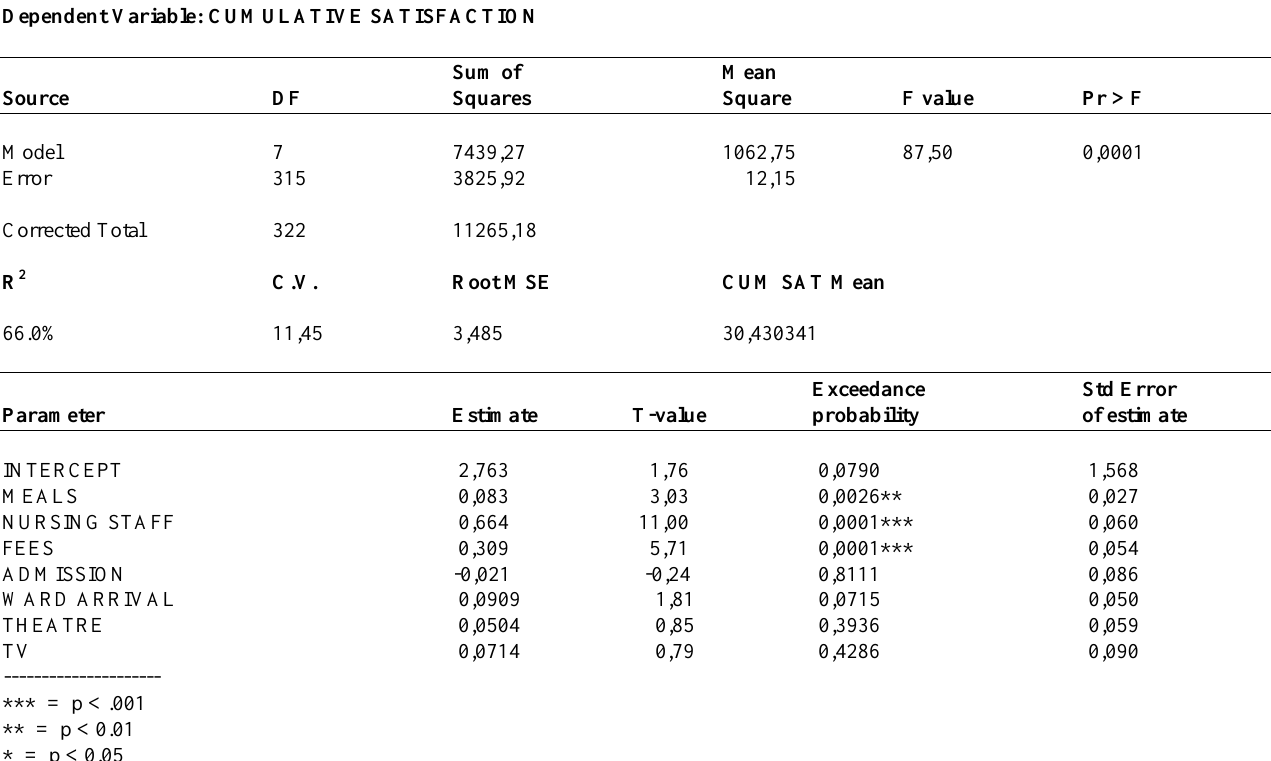
Dependent Variable: CUMULATIVE